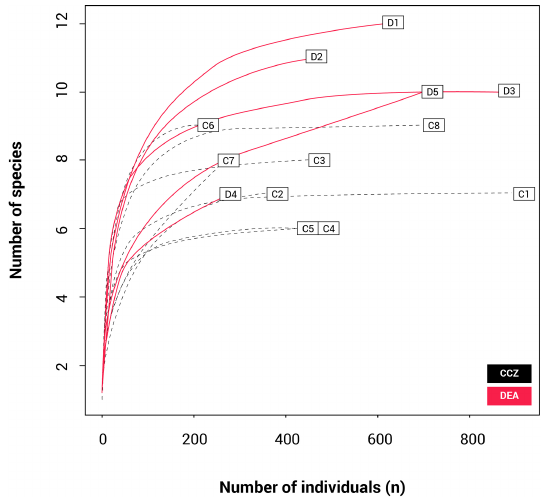
Figure 4. Species rarefaction curves for each of the 13 trap stations across both areas, the Clarion–Clipperton fracture zone and the Dis- COL experimental area. Only individuals longer than 15mm were considered here.